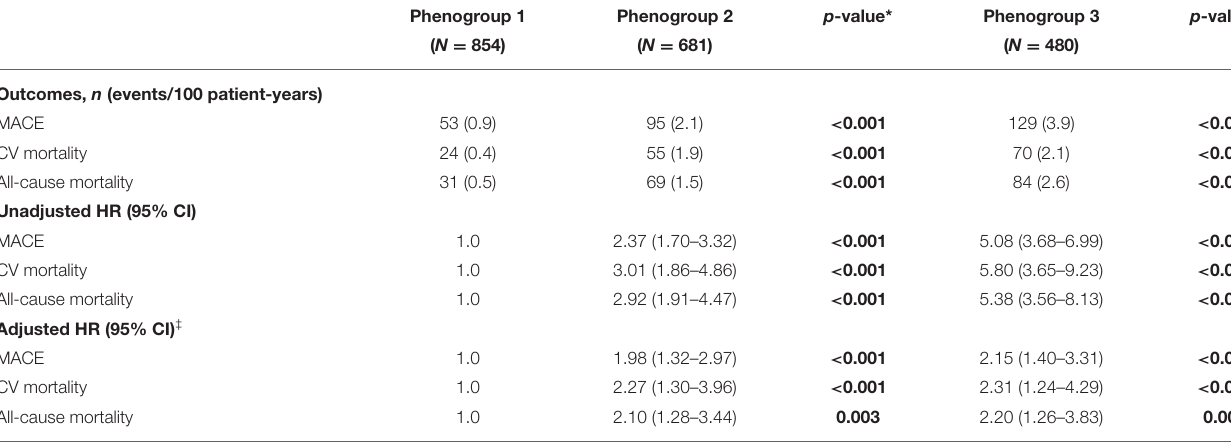
TABLE 2 | Association of phenogroups with adverse outcomes on cox proportional hazard analysis.